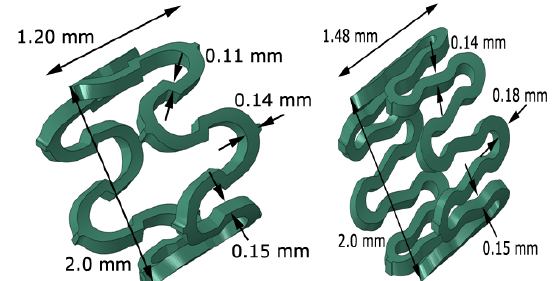
Figure 5: One ring 3D FE models of the optimized stent (left) and the patented stent (right) used in the degradation process simulations.